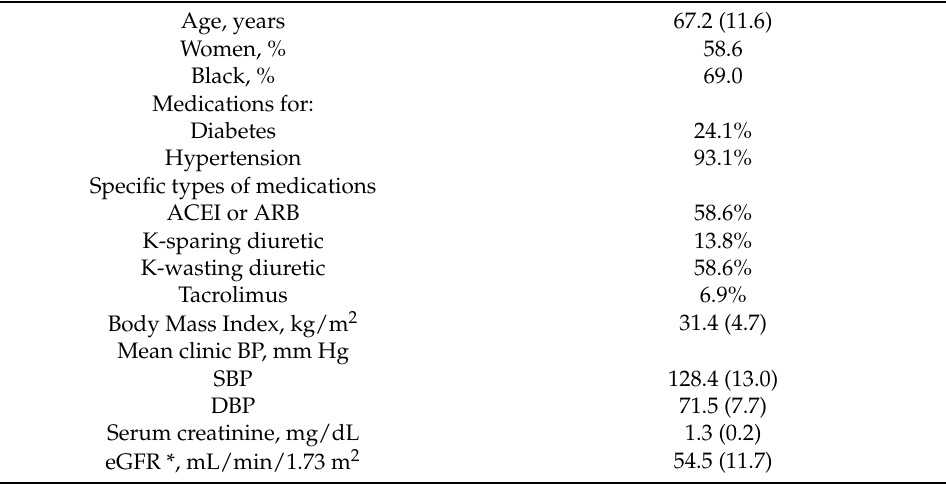
Table 2. Baseline Characteristics ‡ of All Randomized Trial Participants ( N = 29).